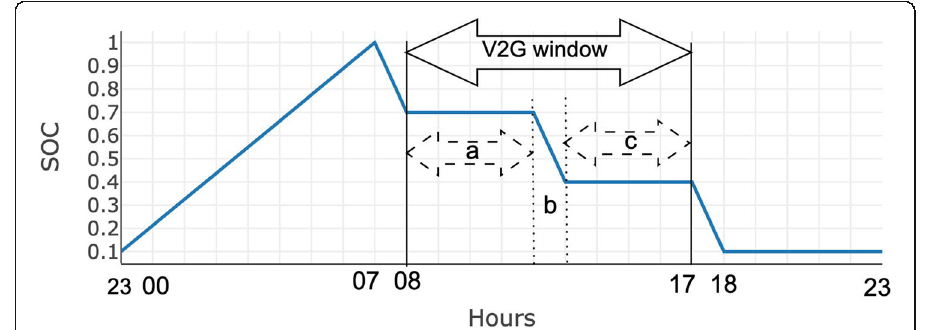
Fig. 3 SOC profile of an EV with one V2G discharge